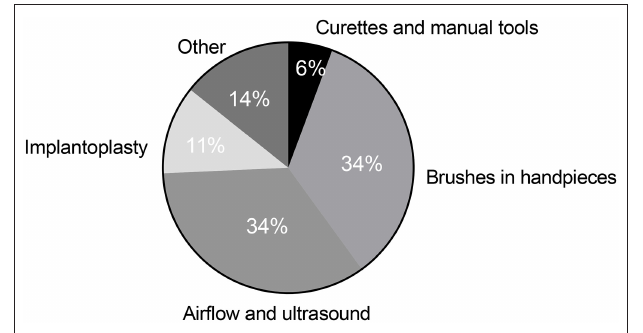
FIGURE 4 | Mechanical treatment preferences.